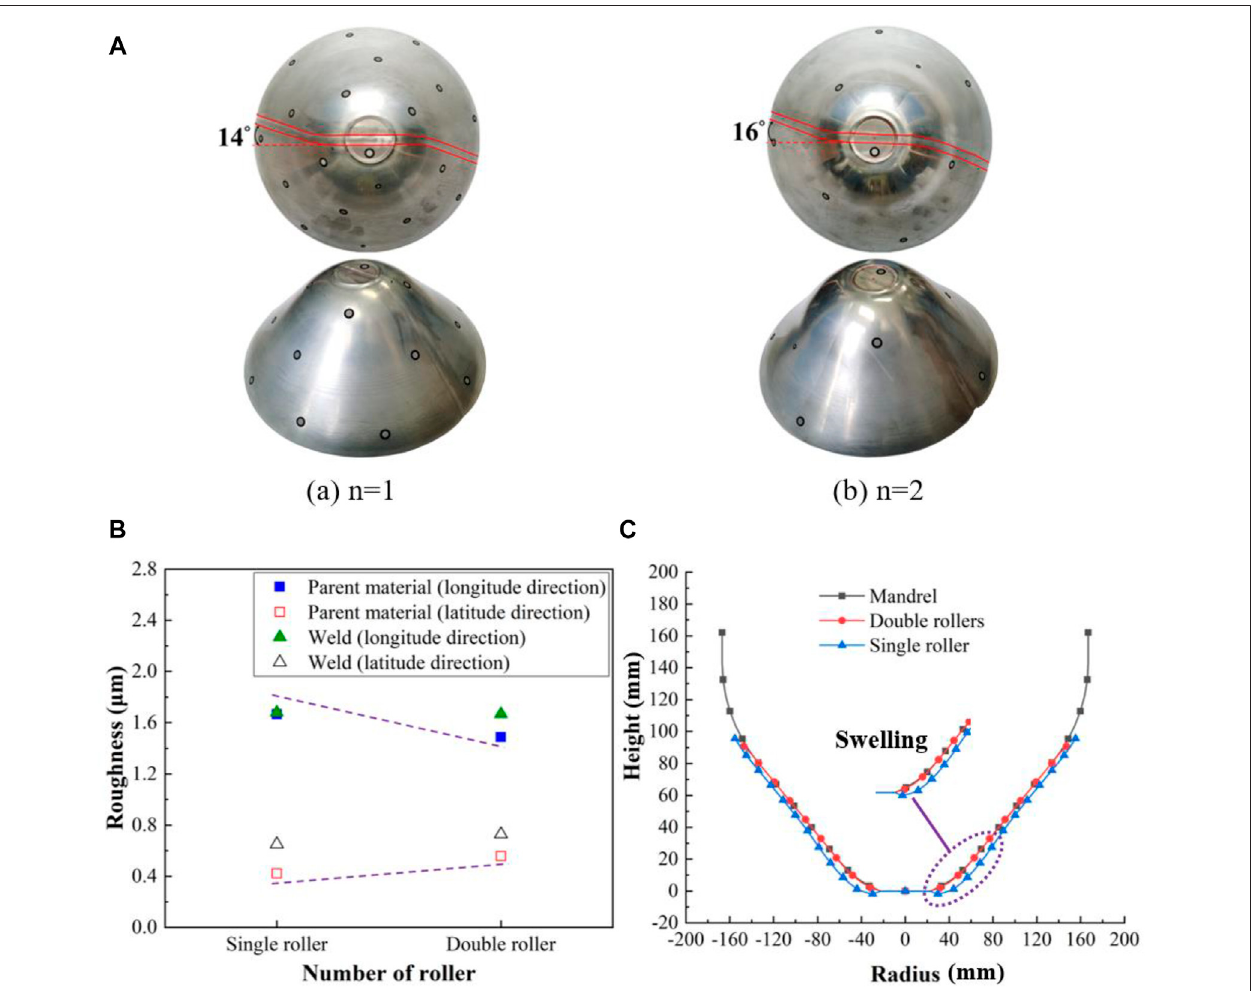
FIGURE5| Experimental results: (A) topand oblique viewsofspunparts undertherollersnumberof(a) n (cid:1) 1,(b) n (cid:1) 2; (B) surfaceroughnessesofspunparts and (C) forming pro fi le of spun parts.